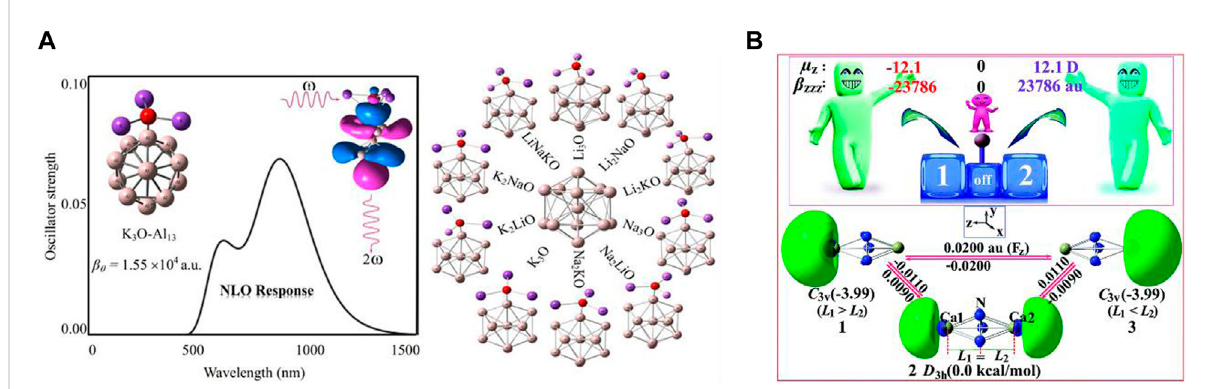
FIGURE 3 (A) Structures of superalkalis, M 3 O (where M = Li, Na, and K) associated with the Al 13 nanocluster reproduced with permission from Omidvar (2018); (B) different con fi gurations (1, 2, and 3) of the CaN 3 Ca molecule adopted from Wang et al. (2020) with permission from the Royal Society of